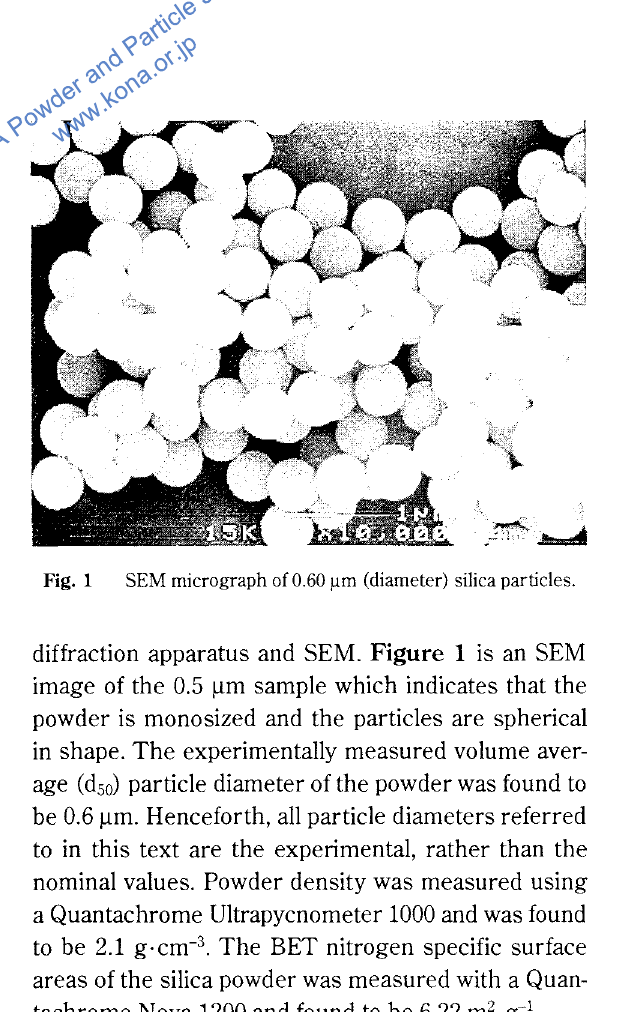
Fig. 1 SEM micrograph of 0.60 ).lm (diameter) silica